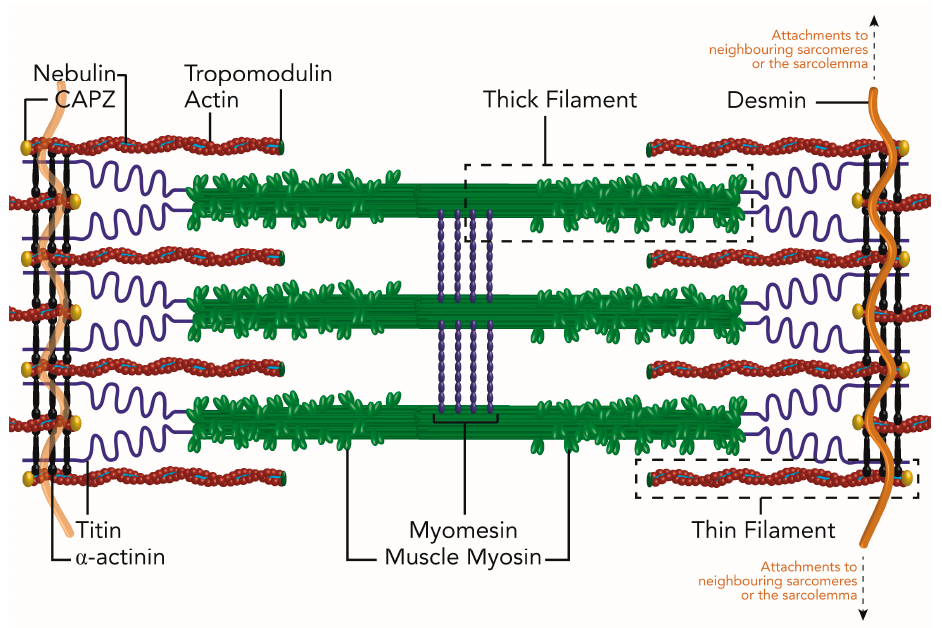
Figure 1. Simplified schematic of the mature sarcomere in striated muscle. The major components of the mature sarcomere are shown. The Z-disc, composed mainly of α -actinin, denote the boundaries of individual sarcomeres, add stability and act as attachment sites for signaling factors, neighboring myofibrils and the myocyte cell membrane (sarcolemma). Thin filaments made of actin, nebulin and tropomodulin extend from the Z-disc to interact with the globular head domains of the myosin thick filaments that protrude out from the M-line toward the Z-disc. The binding of myosin to actin, of the thin filaments, allows the thick filaments to pull the Z-discs toward the center of the sarcomere resulting in contraction/shortening of the sarcomere length. The protein giant, titin and the elastic properties of myomesin in the M-line buffer the contraction of the sarcomere. Desmin is incorporated into the Z-discs of sarcomeres to help stabilize sarcomere structure, align sarcomeres in neighboring myofibrils and connect the contractile structures to the sarcolemma.